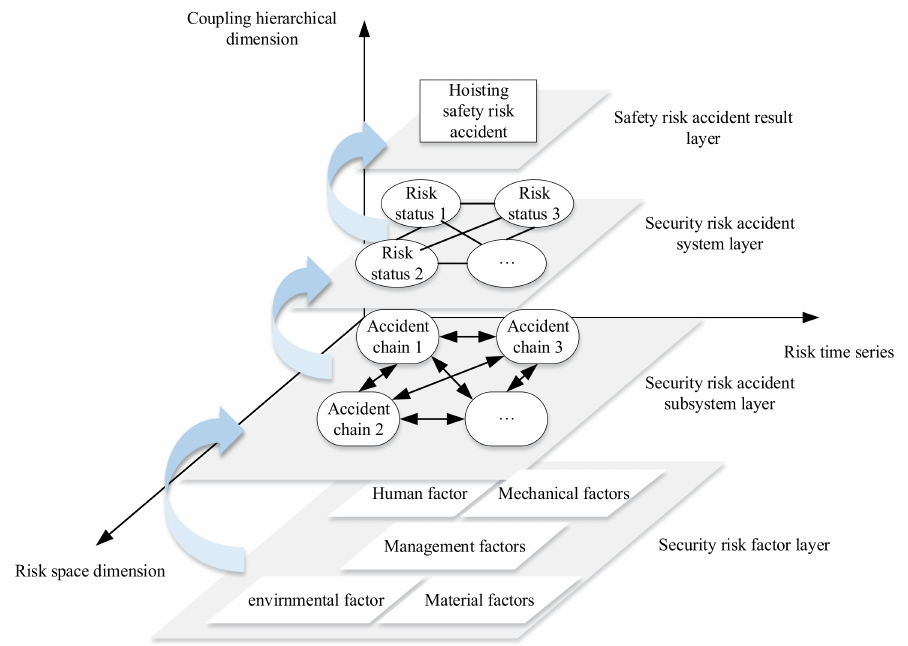
Figure 5. Coupling level diagram of safety risk accidents in prefabricated building